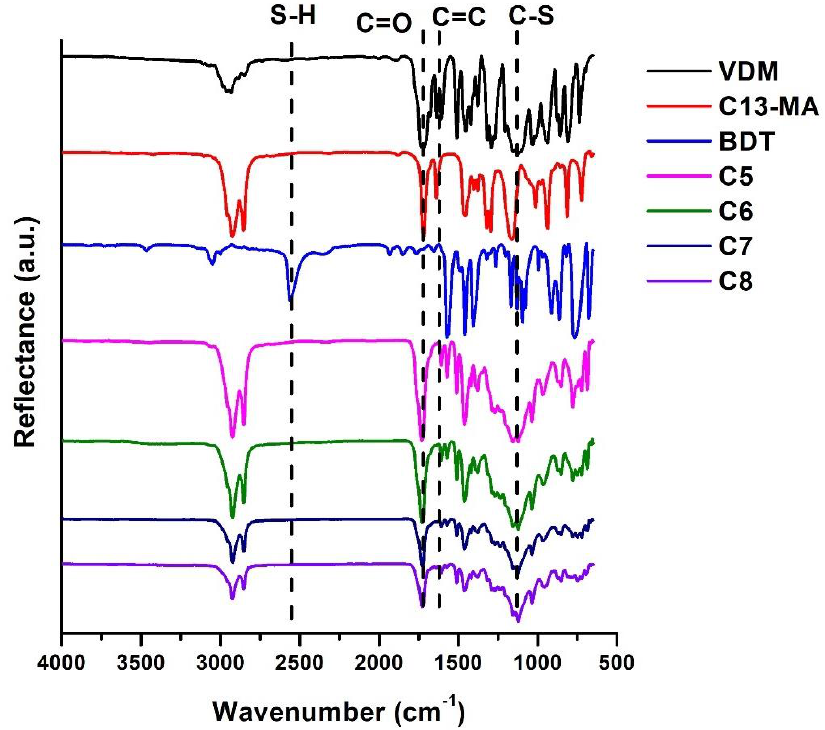
Figure 3. FT-IR spectra of VDM, C-13MA, BDT, and cross-linked polymers C5 – C8 . Table 3. Yield of insoluble fraction, thermal, and thermomechanical characteristics of the